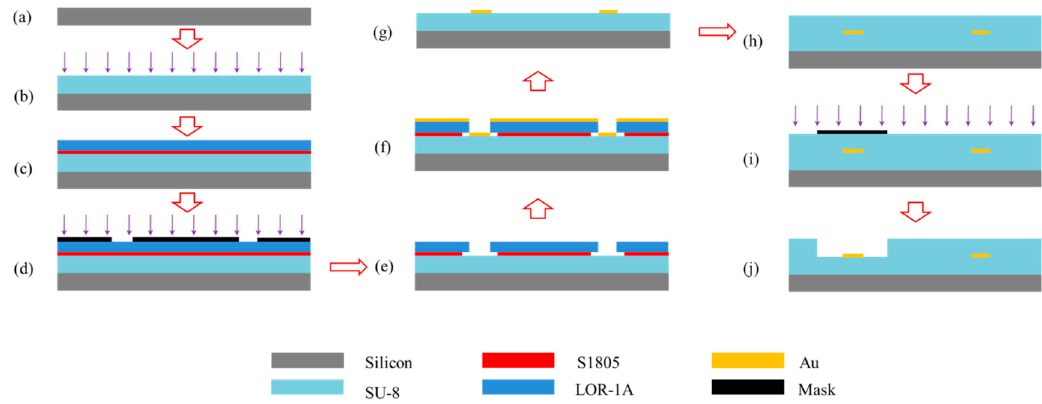
Figure 9. Fabrication process flow of LRSPP waveguide sensors. ( a ) silicon substrate preparation, ( b ) spin-coating and curing of SU-8 bottom cladding, ( c ) LOR-1A and S1805 stack formation, ( d ) UV photolithography, ( e ) LOR-1A and S1805 development, ( f ) Au thermal deposition, ( g ) double-layer lift-off, ( h ) spin-coating and curing of SU-8 upper cladding, ( i ) UV photolithography, ( j ) development.